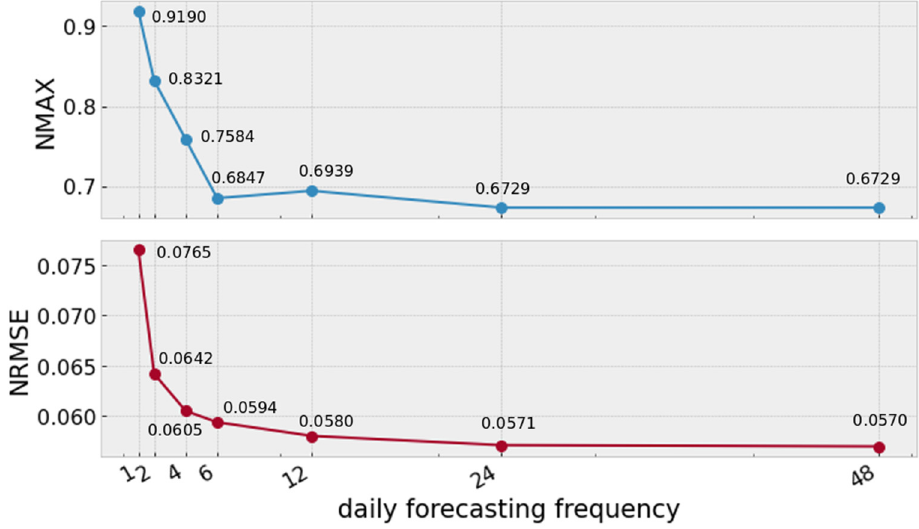
Figure 8. Error metrics on GEPP for different values of daily forecasting frequency in Scenario 4.